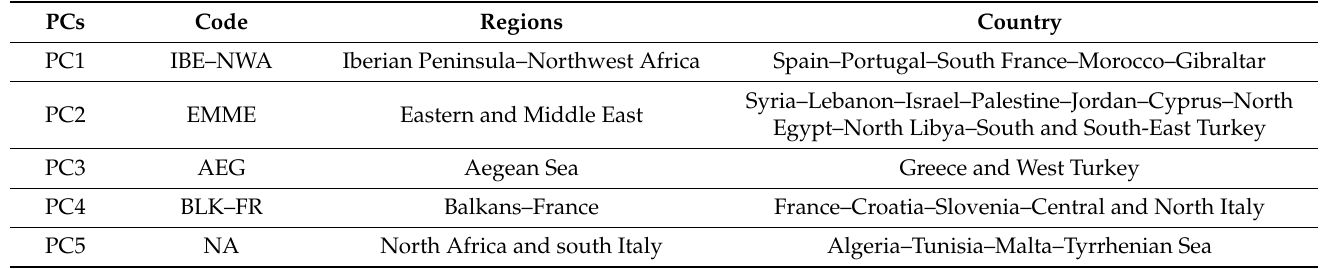
Table 3. The five subregions identified by five PCs for DXI-12 over the